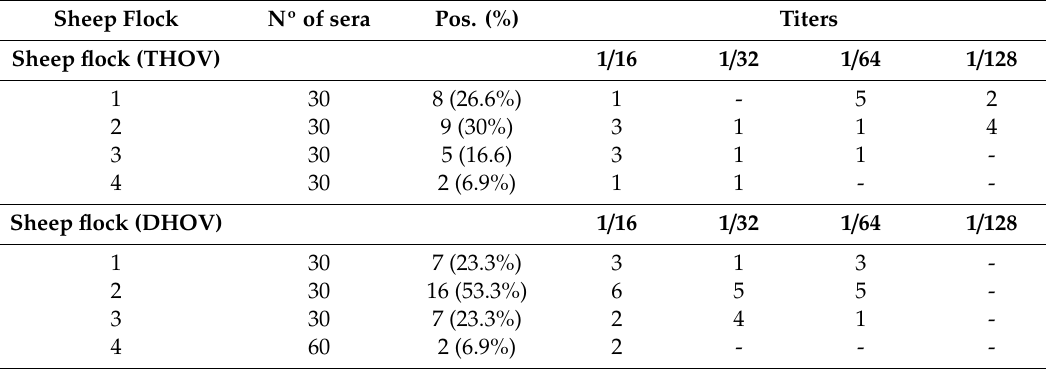
Table 4. Seroprevalence and antibody titers for the di ff erent flocks.